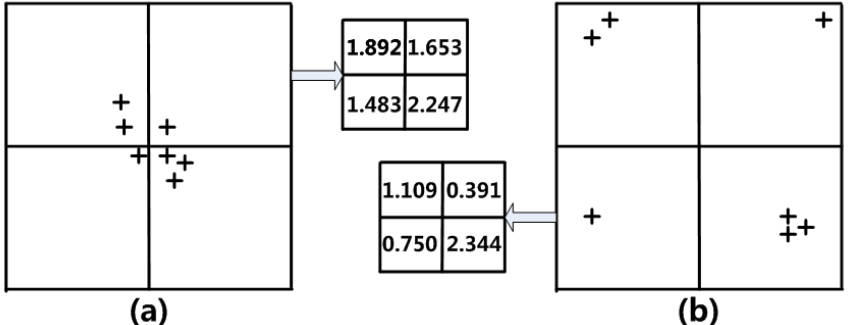
Figure 5. In the conventional algorithm, the grid cumulative contribution is used as the grid density diagram. ( a ) No cumulative contribution results; ( b ) Under cumulative contribution results.